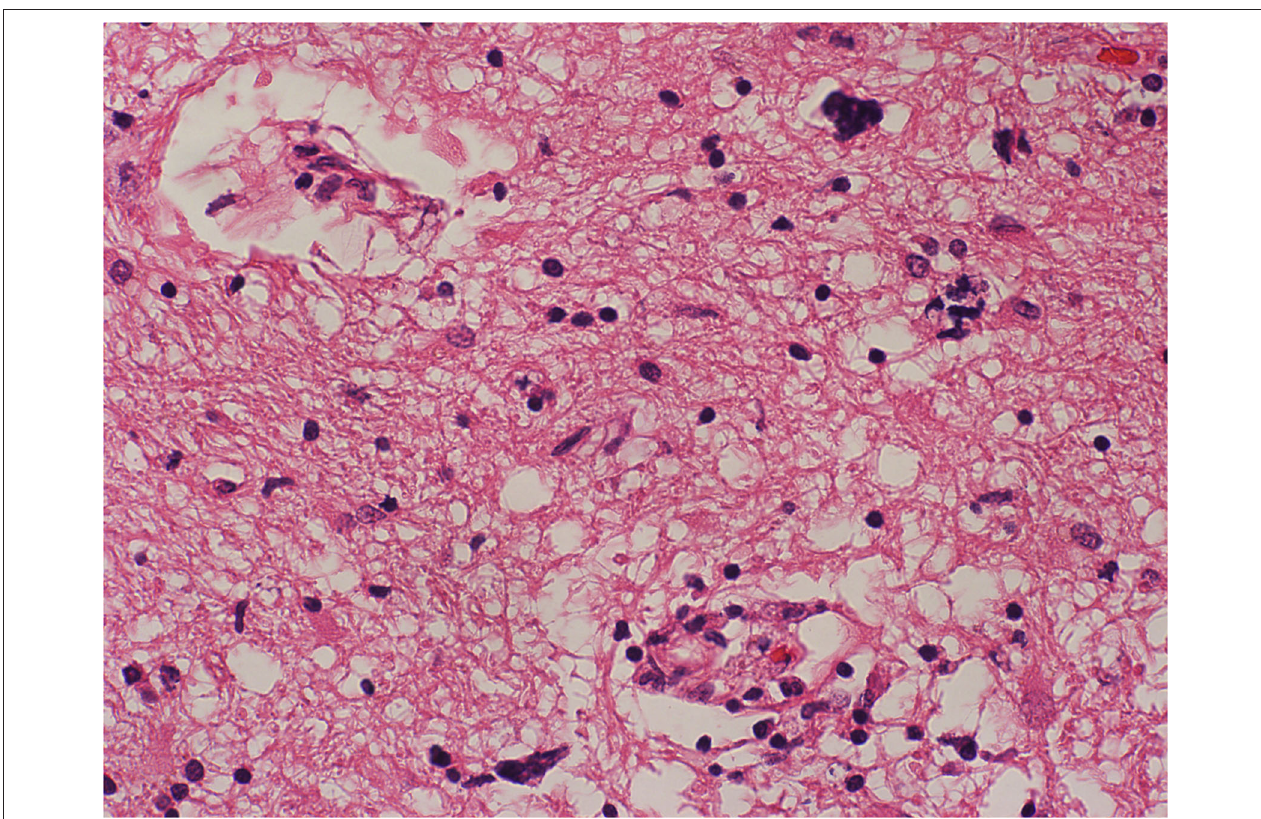
FIGURE 10 | Cerebral white matter with three shrunken multinucleate giant cells; this is inactive variant HIV-CD8E (Case 23). Also present are lymphocytes, enlarged astrocytes, and microglia. Haematoxylin and Eosin stain. Original magnification ×